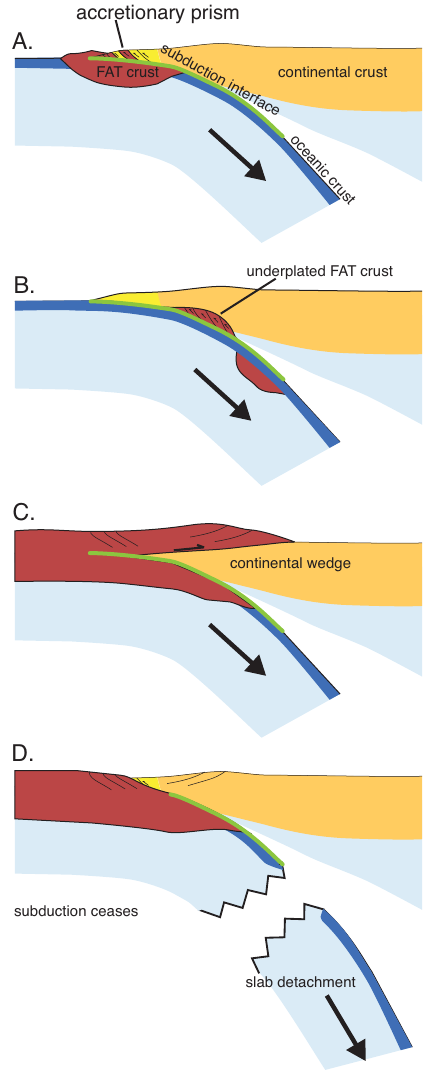
Figure 1. Cartoon schematics of FAT crust in subduction zones for four accretionary processes: (a) accretion in the accretionary prism, (b) subcretion, (c) flake tectonics, and (d) collision. In (a) , sedi- ments and crustal units from the subducting oceanic plate and FAT are scraped off and accumulated in the accretionary prism in front of the fore-arc. The majority of the FAT crust is subducted. Subcre- tion (b) occurs below the accretionary prism, as crustal slices of the FAT are sheared and thrust onto the overriding continent. (c) Flake tectonics is the accretionary process where FAT crust is obducted onto the overriding continent, likely over a thick, strong prism of metasedimentary rocks in the overriding plate. (d) Collision will occur for large FATs, after some of the crust has subducted and ac- creted. The subducting slab may eventually